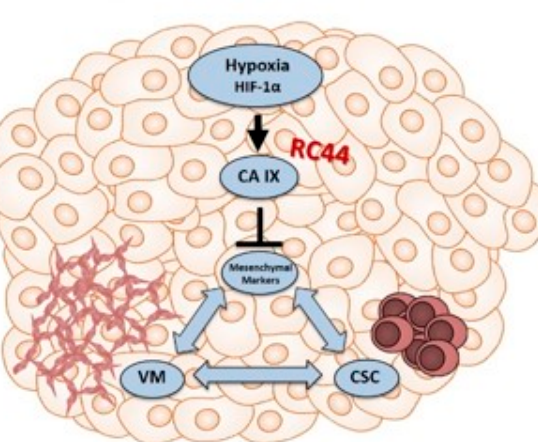
Figure 9. Schematic model illustrating that targeting hypoxia-induced cell plasticity through CA IX inhibition could be a new opportunity to selectively hamper VM and CSCs through mesenchymal marker inhibition. (Hypoxia-inducible factor (HIF-1 α ); carbonic anhydrase IX (CA IX); vascular mimicry (VM); cancer stem cell (CSC).).